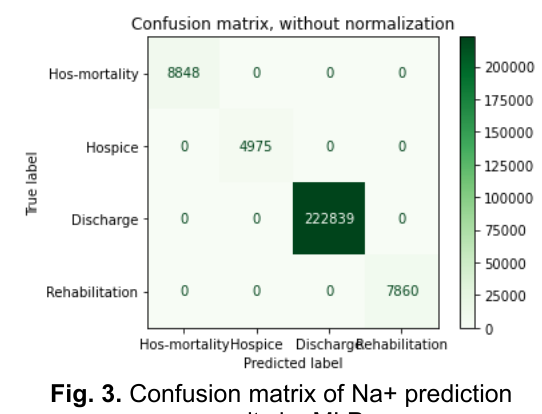
Fig. 3. Confusion matrix of Na+ prediction results by MLP